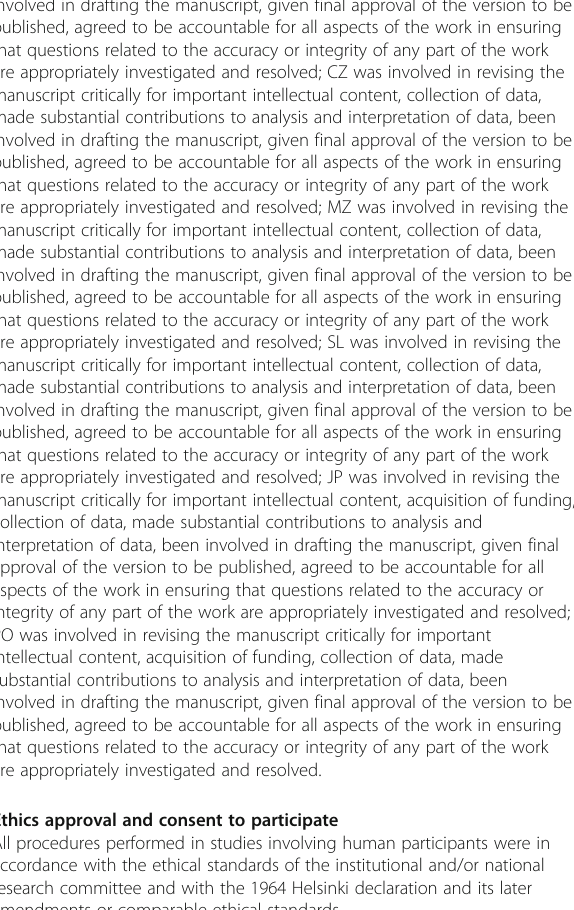
Additional file 1: Table S1. Scale and item characteristics of the SCNS- P&C45-D. (DOCX 23